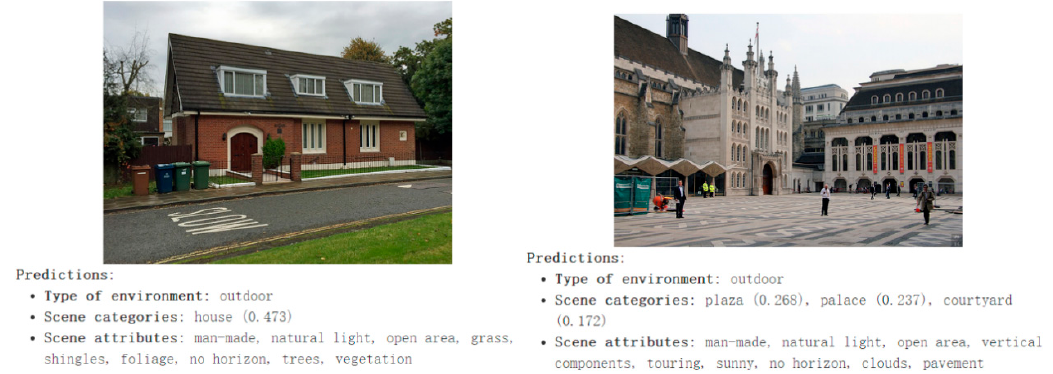
Figure 3. Various kinds of scene recognition results of building-related images.